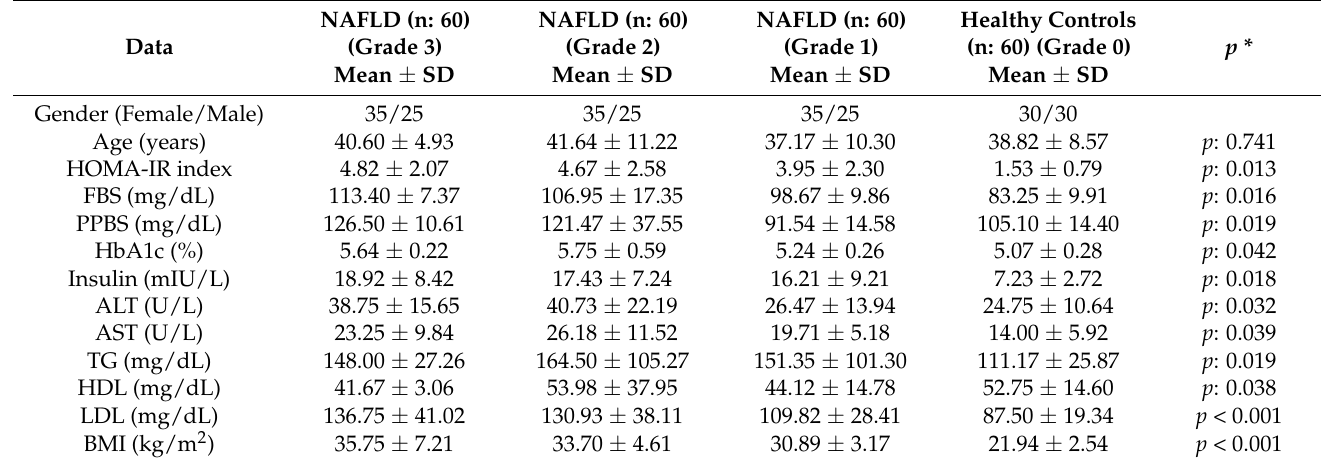
Table 2. Distribution of demographic data of NAFLD patient groups, separated by